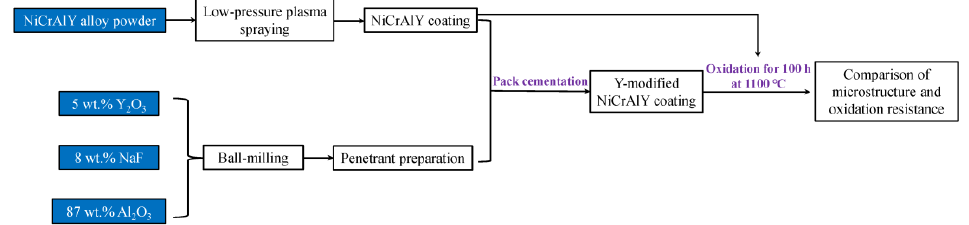
Figure 2. Schematic diagram of research route.